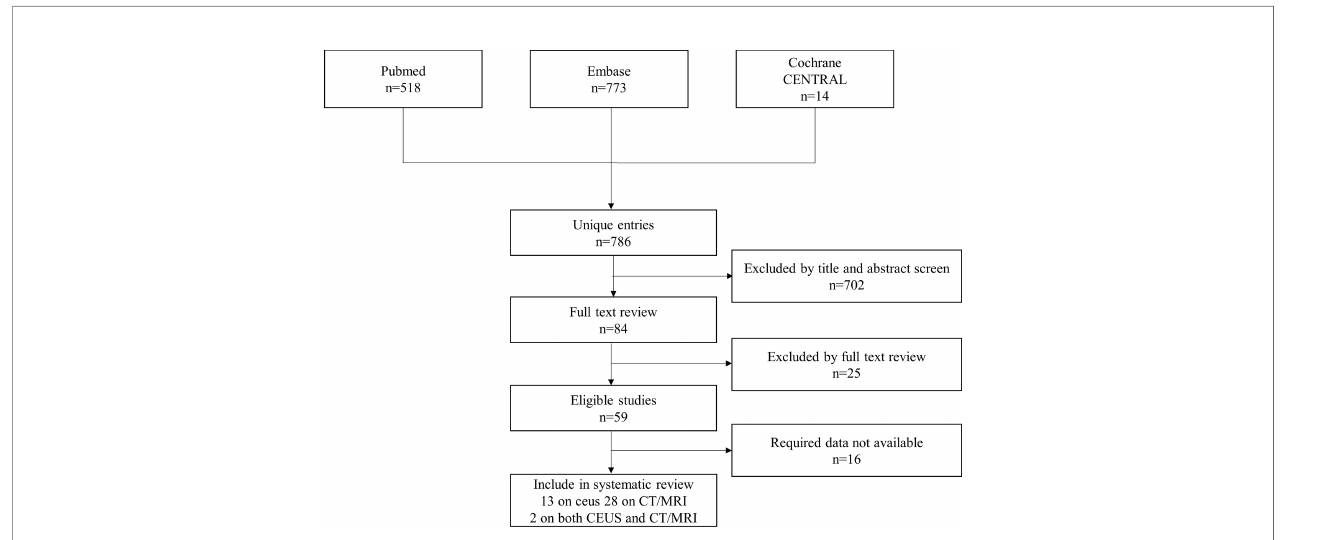
Figure 2 . The forest plots of percentages of HCCs in CEUS and